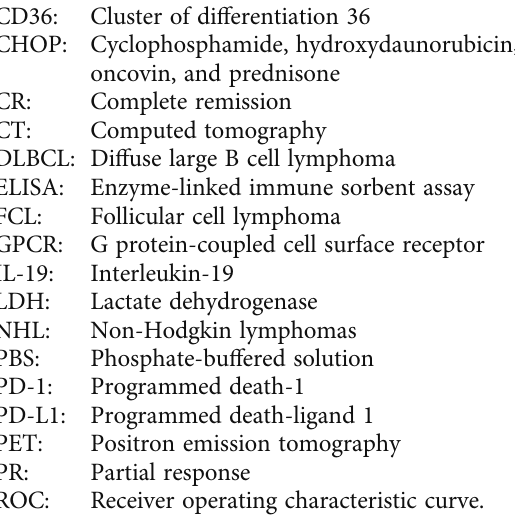
Table S1: characteristics of 78 lymphoma patients and 50 healthy volunteers. Table S2: characteristics of 44 lymphoma patients without extranodal involvement and 34 patients with extranodal involvement. Table S3: pretherapy and post- therapy PD-L1/PD-1 coexpression with CXCR3/CD36 in 34 lymphoma patients with extranodal involvement. Table S4: pretherapy and posttherapy PD-L1/PD-1 coexpression with CXCR3/CD36 in 44 patients without extranodal involve- ment. Figure S1: (a) lymphocytes gating is used to assess positive cells in a lymphoma patient with extranodal involvement; (b) Green P2 represents CXCR3+ lympho- cytes; (c) upper right quadrant representing positive PD-L1 +CXCR3+ cells. Figure S2: (a) lymphocytes gating is used to assess positive cells in a lymphoma patient with extrano- dal involvement; (b) Green P2 represents CXCR3+ lympho- cytes; (c) upper right quadrant representing positive PD-1 +CXCR3+ lymphocytes. Figure S3: (a) lymphocytes gating is used to assess positive cells in a lymphoma patient with extranodal involvement; (b) Green P2 represents CD36+ lymphocytes; (c) upper right quadrant representing positive PD-L1+CD36+ lymphocytes. Figure S4: (a)